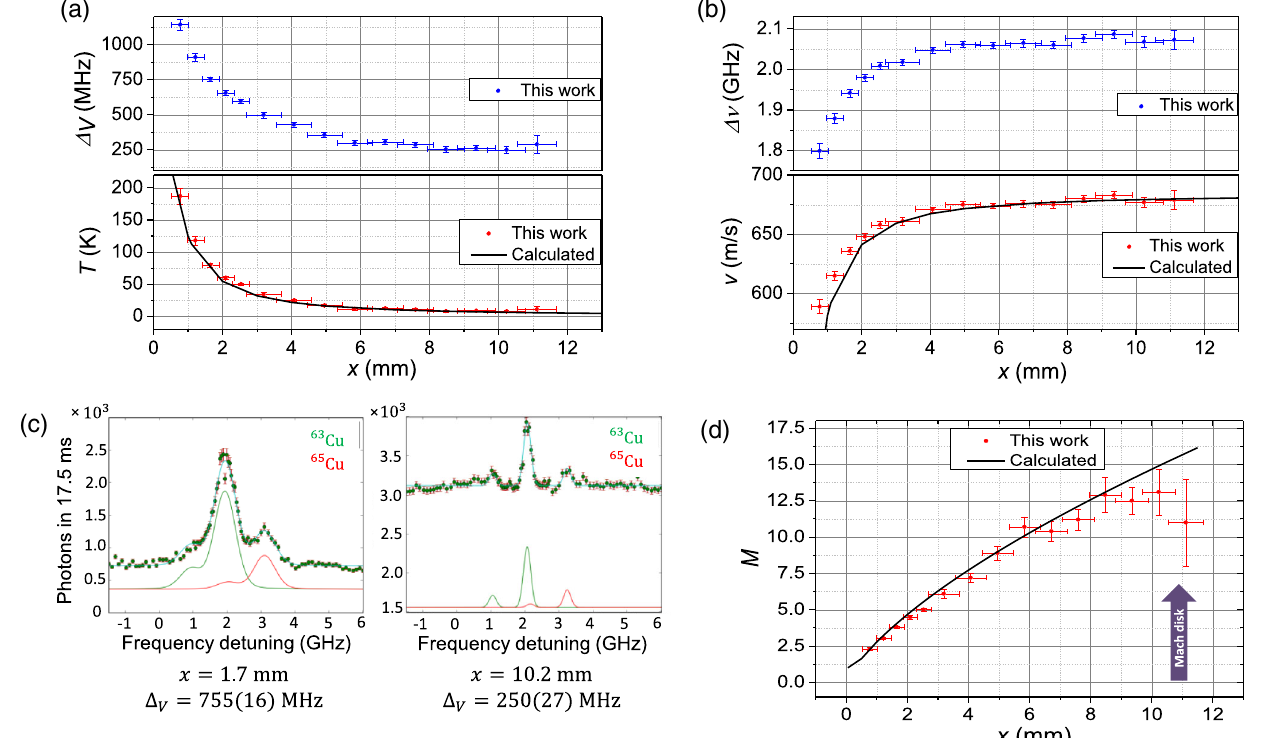
FIG. 10. Variations of the local characteristics along the central jet line in the expanding flow of the supersonic free jet. P ¼ 355 mbar, P ¼ 1 . 3 mbar. (a) Linewidth Δ T . (b) Doppler shift Δ ν and velocity v . (c) The hyperfine spectra of 0 V and temperature bg the transitions from the hyperfine level F ¼ 1 of the ground state 4 s 2 S 1 = 2 to the hyperfine levels F ¼ 1 0 and F ¼ 2 0 of the excited state 63 ; 65 Cu at two x coordinates from the nozzle exit. (d) Mach number M . Calculated black curves show the outcome after using 4 p 2 P 1 = 2 in Eq. (10) [and Eqs. (11) and (12) for x=d (cid:2) < 1 ] as well as Eqs. (13) and (15) ( T 0 ¼ 450